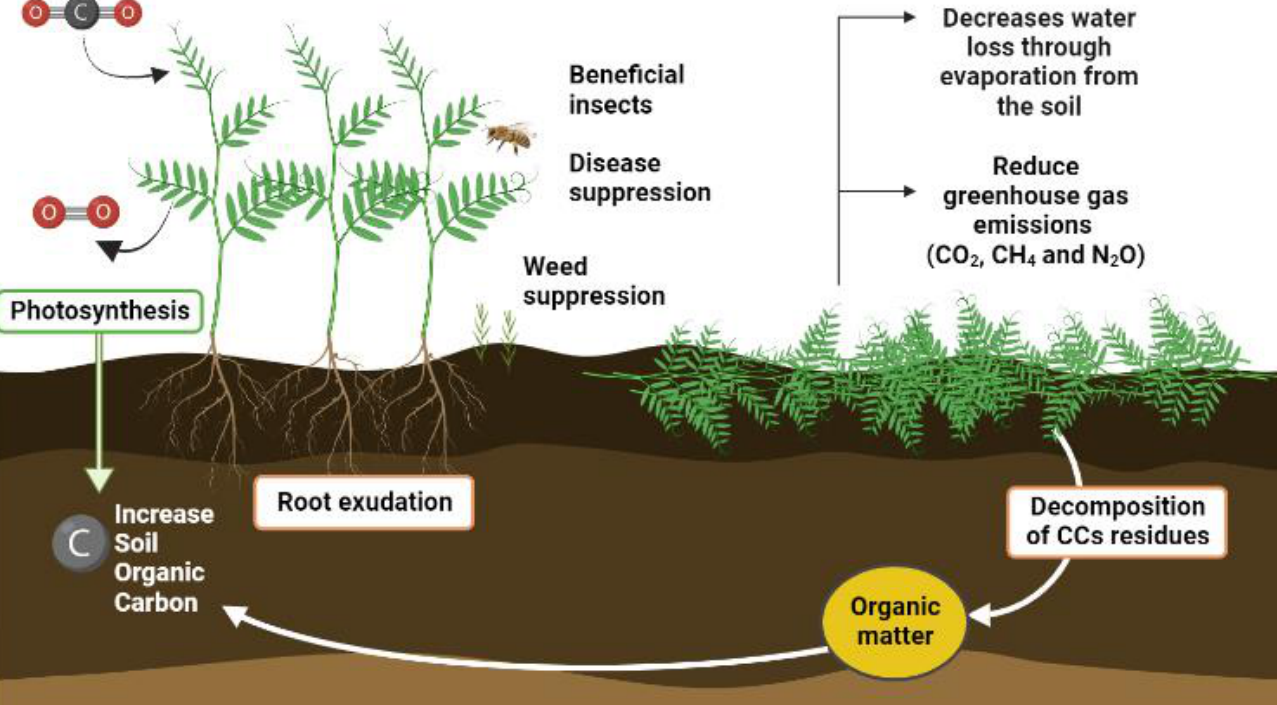
Figure 3. Ecological services associated with cover crops.